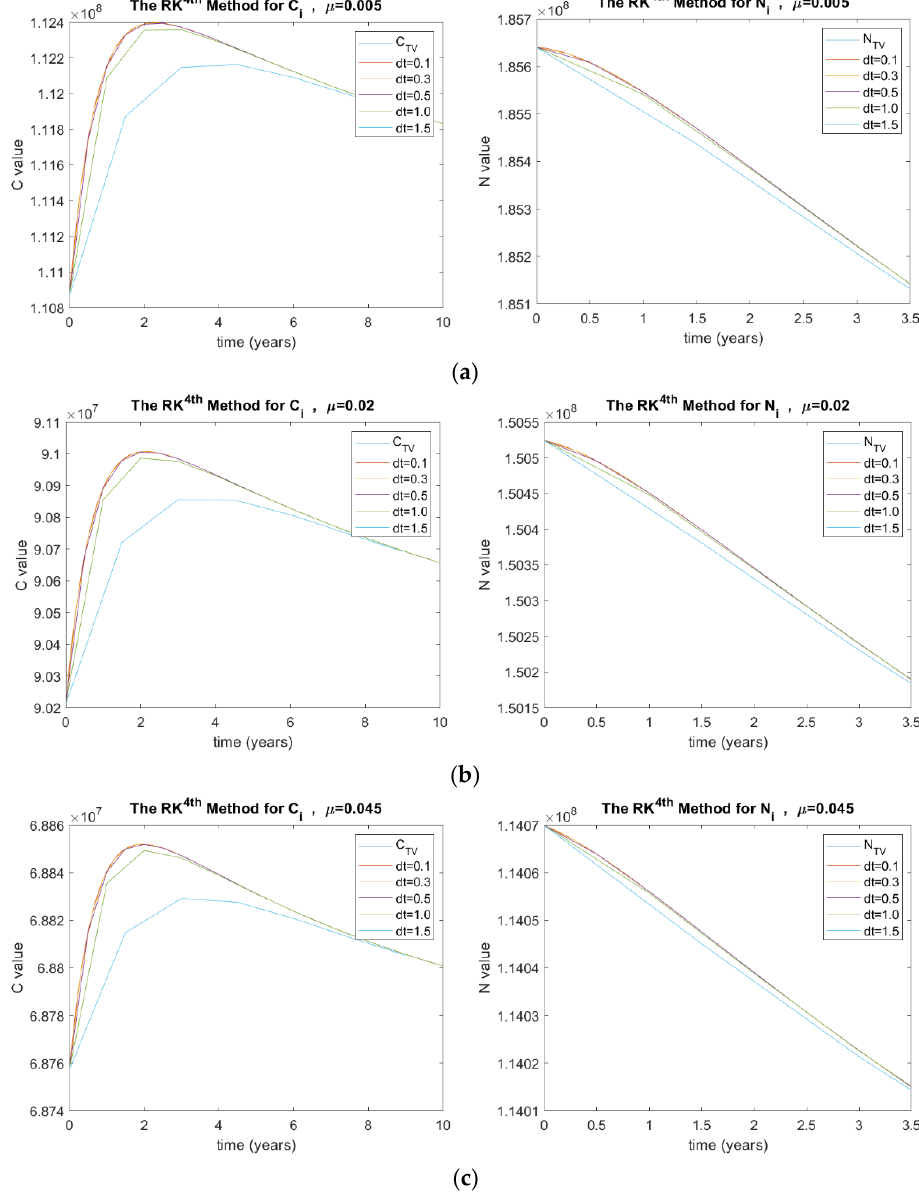
Figure 6. ( a ) Stability analysis for the RK method when µ = 0.005, ( b ) µ = 0.02, ( c ) and µ = 0.45, where C is the number of diabetic patients with complications and C TV is its true value, N is the total number of people with diabetes and N TV is its true value, and d t is the time step size. The Rate at Which Patients with Complications Become Severely Disabled ( v ) The investigated v values in this paper are 0.03, 0.05, 0.1, and 0.35. Figure 7 shows the results of C i and N i for the RK method in terms of v and ∆𝑡 , where (a) v = 0.03 , (b) v = 0.05 , (c) v = 0.1 , and (d) v = 0.35 .